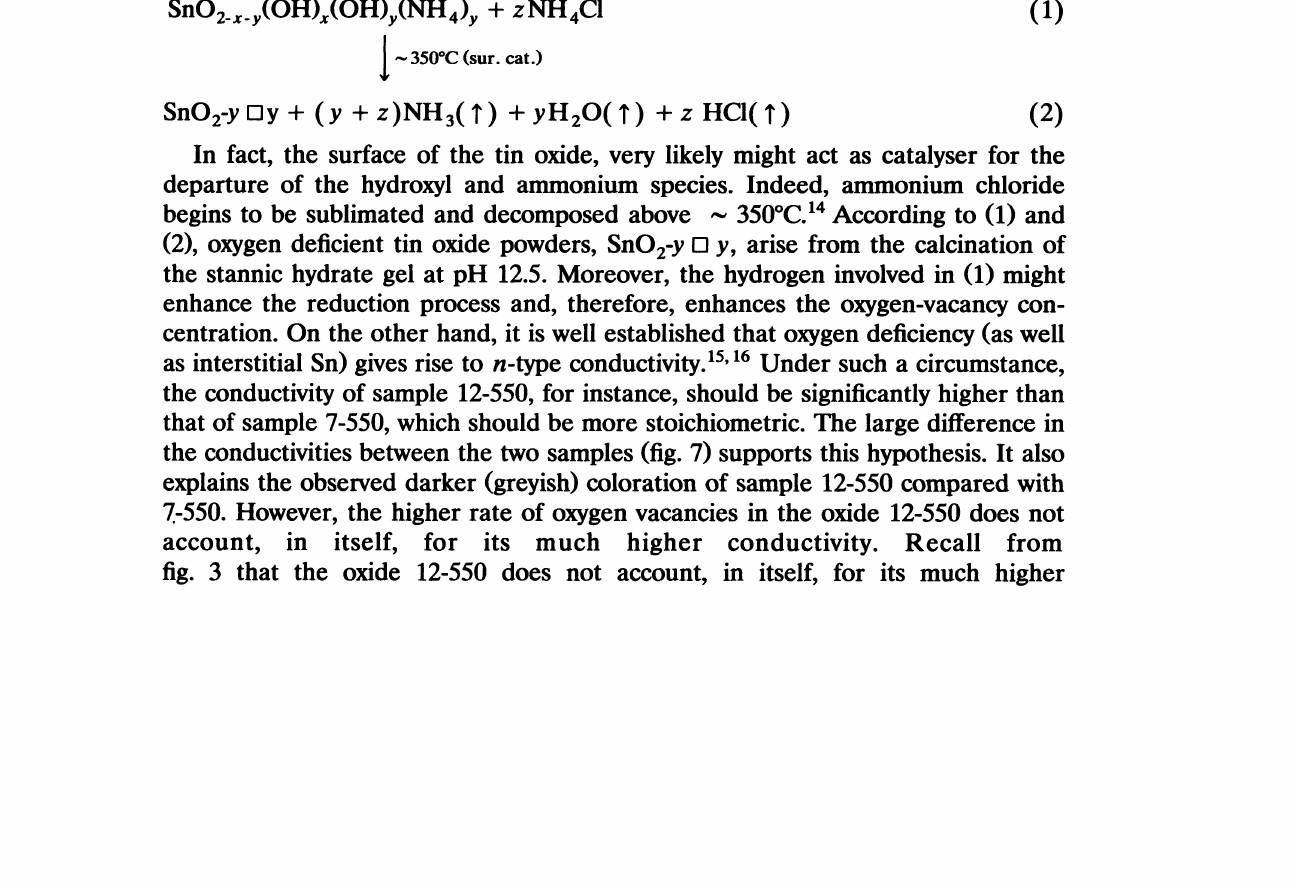
FIGURE 3 X-ray diffractograms of, 12-550, (a), and 7-550 (b) samples (+/- 6